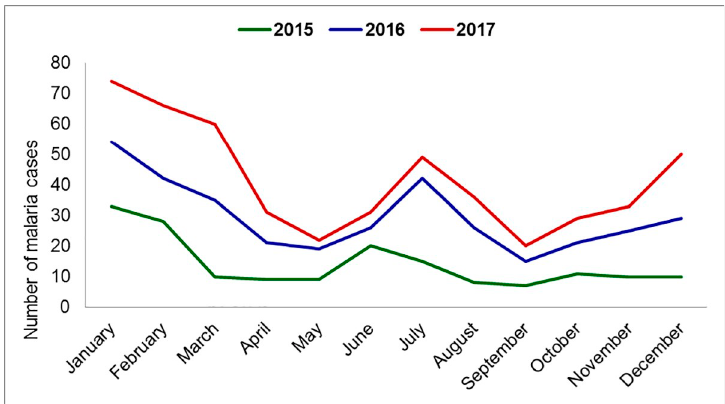
Fig 3. Chronological distribution per month of malaria cases in the Darien Region, Panama. 20015 to 2017.